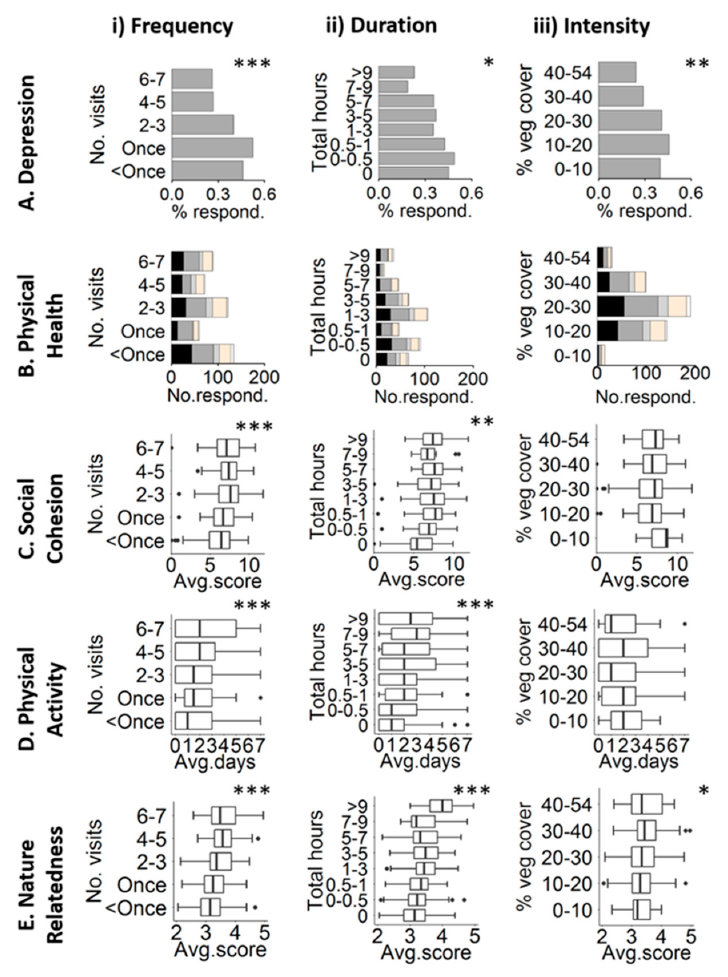
Figure 1. The relationship between health responses ( A − E ) and nature exposure, comprising ( i ) frequency of garden visits, ( ii ) duration of garden visits and ( iii ) neighbourhood nature intensity, measured as the percentage vegetation cover within a 250 m buffer of the centre of the respondents’ postcodes. We show significant relationships within the regression models outlined in Table 1, and error bars are standard errors. Physical health (B) shows the number of respondents for each nature dose that had very good (white), good (light grey), average (medium grey), poor (dark grey) and very poor (black) self-reported health. Significance ( * p <0.05; ** p < 0.01; *** p < 0.001).